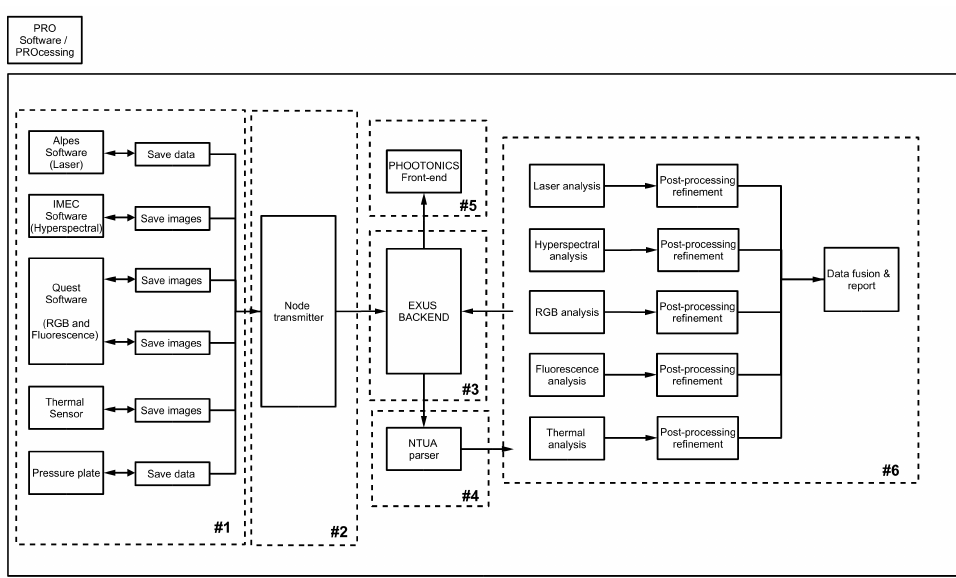
Figure 16. Overview of the adopted software